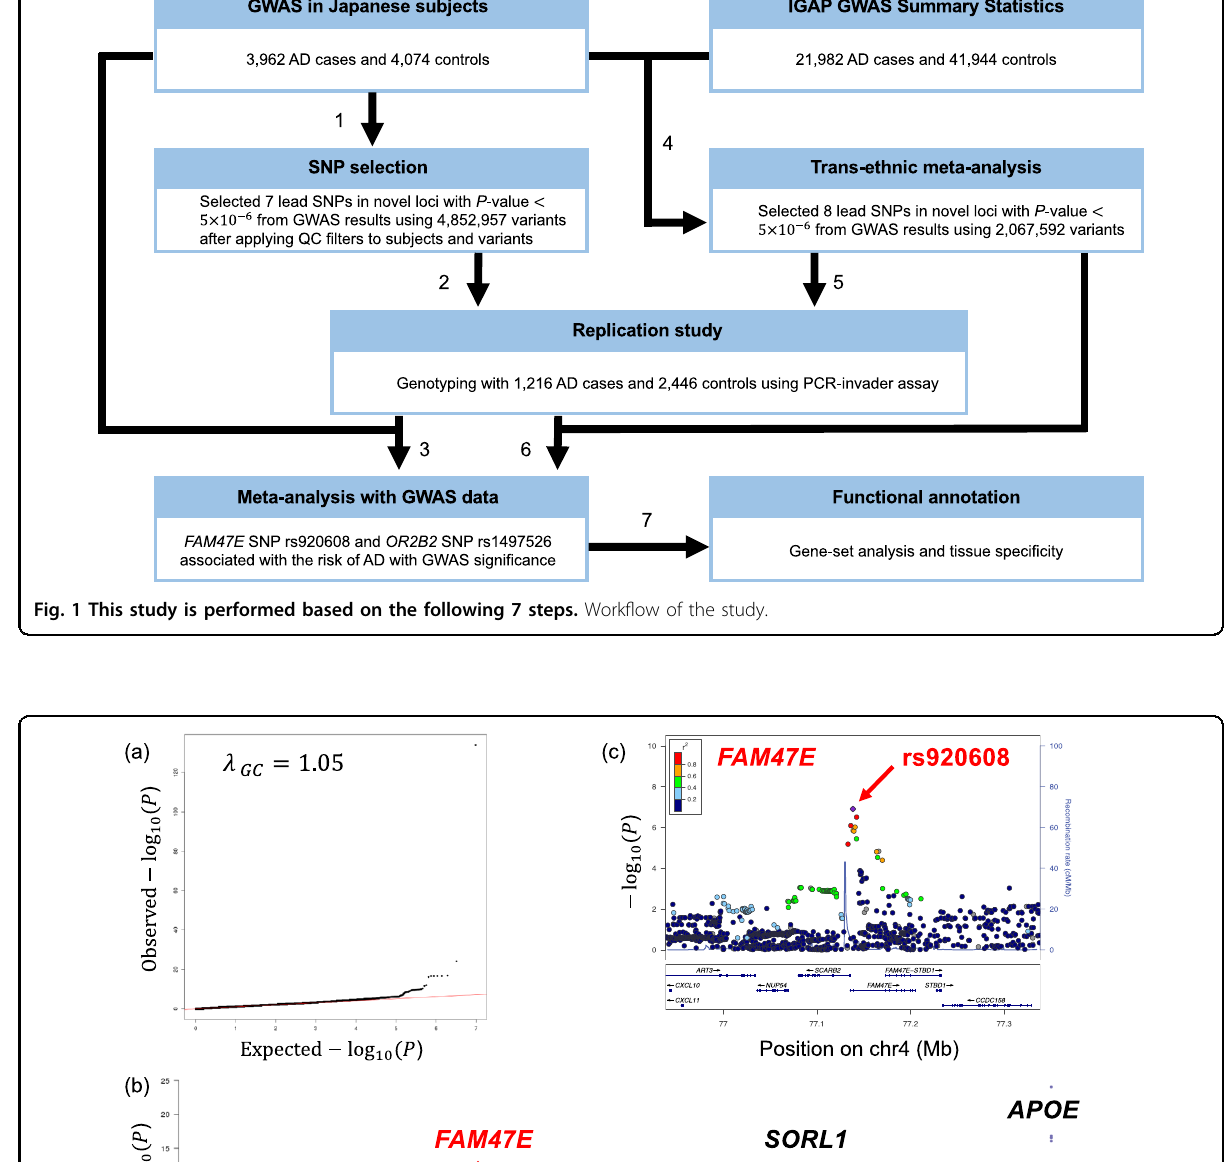
ratio = 0.65, 95% CI = 0.57 – 0.75, Table 1). As the FAM47E SNP genotypes obtained from the GWAS data GWAS data set ( n = 7562) by PCR-invader assay and